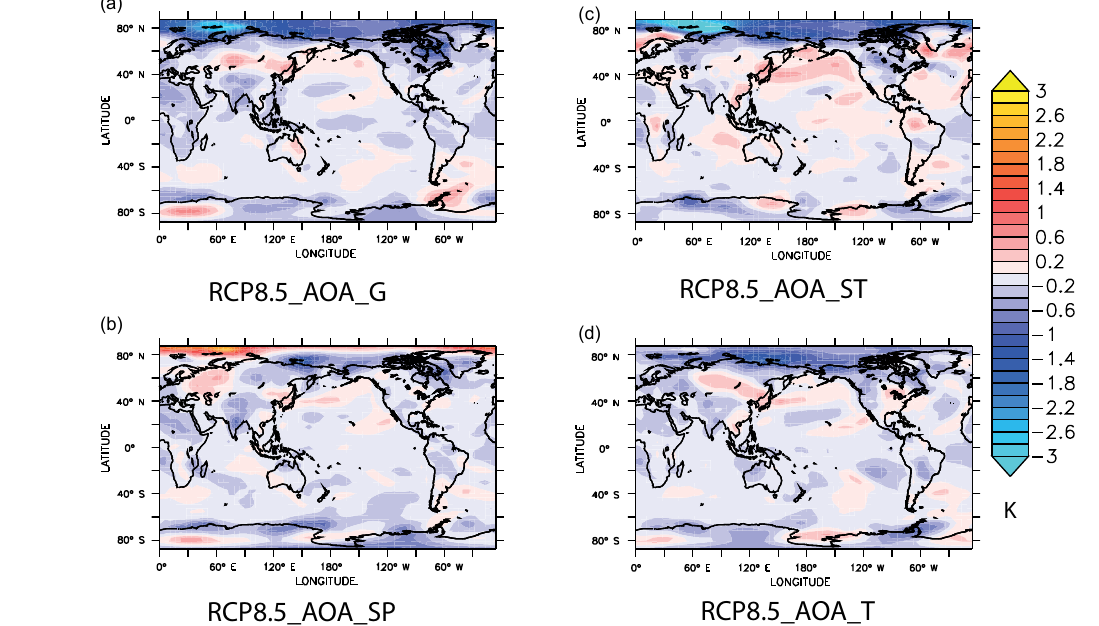
Figure 7. The spatial map of the changes in surface air temperature 2090 (mean; 2081–2100) associated with global and regional AOA under RCP8.5, relative to RCP8.5 with no AOA. Units are